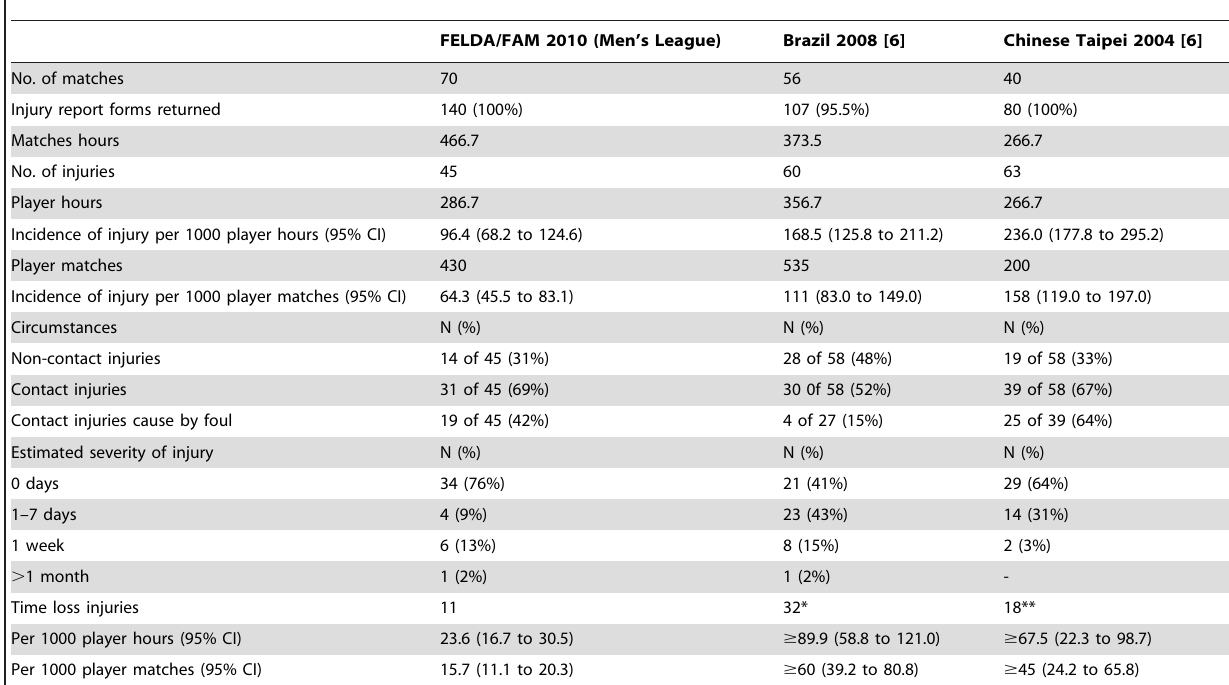
Table 4. Incident and characteristics of injuries during the 2010 FELDA/FAM National Futsal League and World